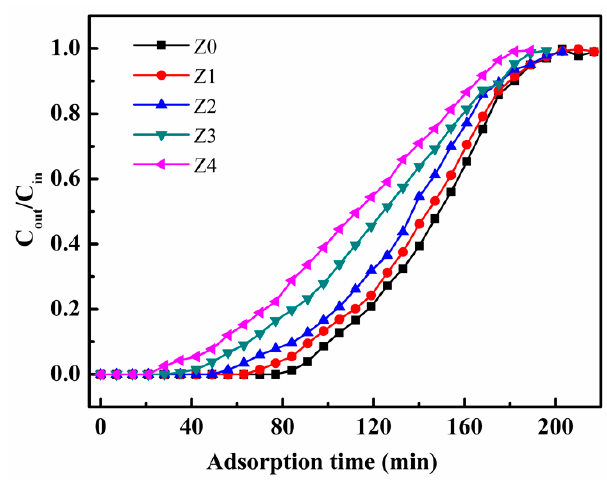
Figure 5. The breakthrough curves of toluene adsorption for different catalysts. Table 3. The adsorption capacity of as-prepared catalysts for different contaminants. Equilibrium Adsorption Capacity (mg/g) Sample